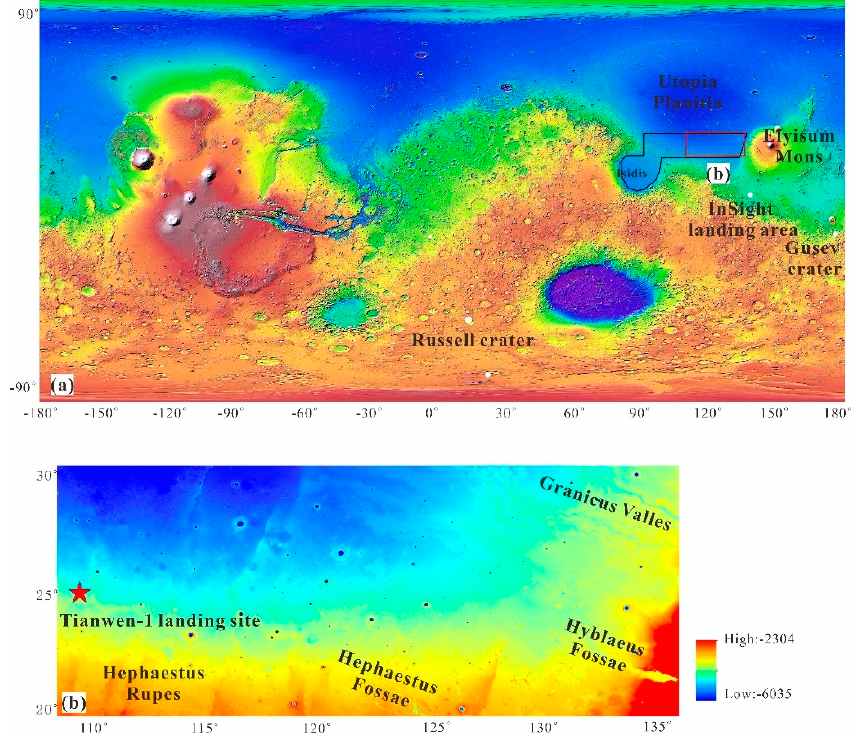
Figure 1. ( a ) The tentative landing area (black polygon) of Tianwen-1 in a rendered elevation map from Mars Global Surveyor (MGS) Mars orbit laser altimeter (MOLA) DEM data with a simple cylindrical projection. ( b ) The elevation map of the study area (red rectangle in Figure 1a). The red five-pointed star represents the landing site of Tianwen-1.